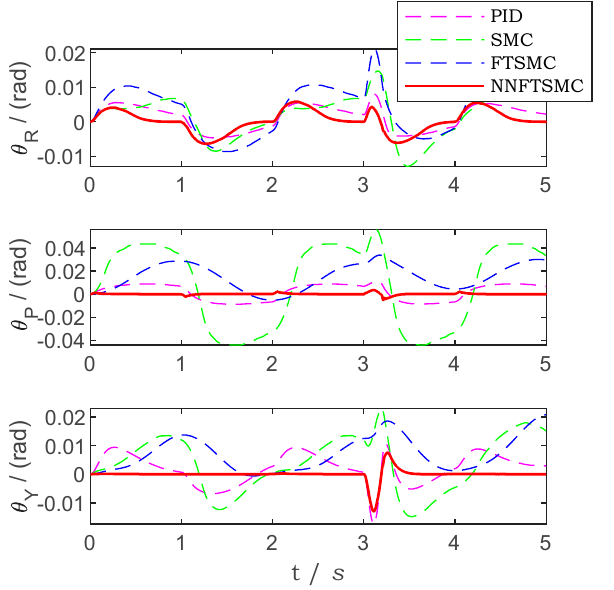
Figure 14. The attitude of the platform by using different controllers in the simulation of attitude locking.